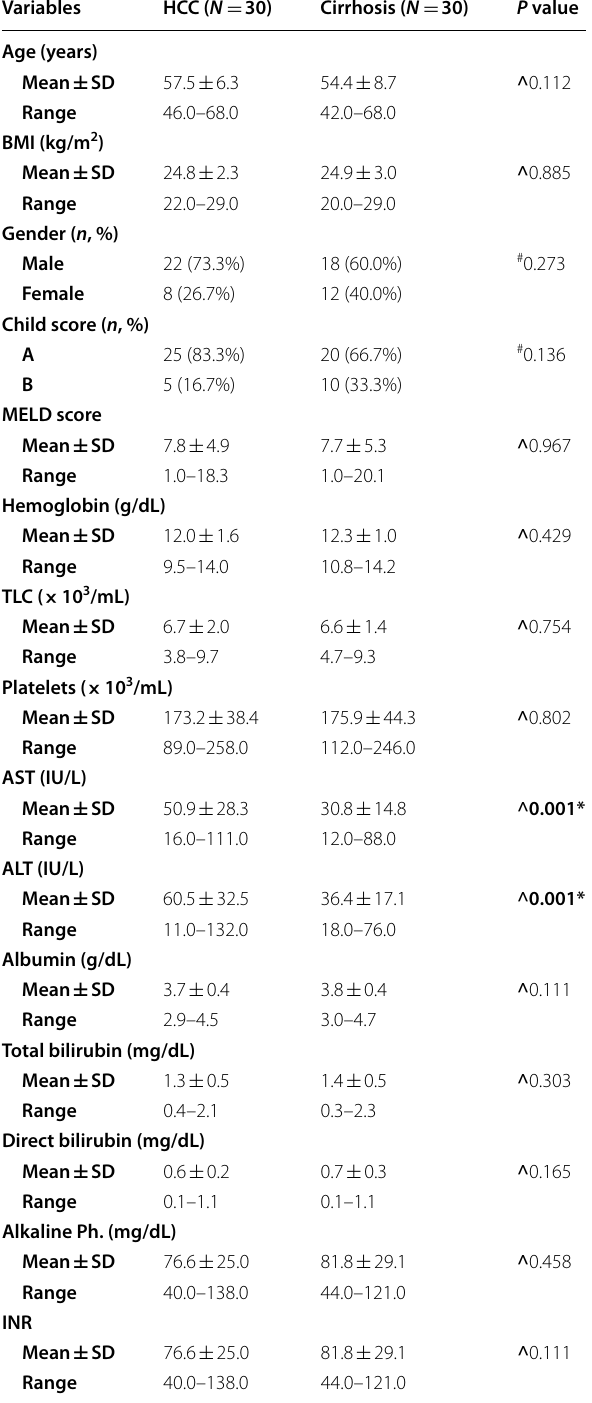
Table 1 Demographic and laboratory parameters of the studied